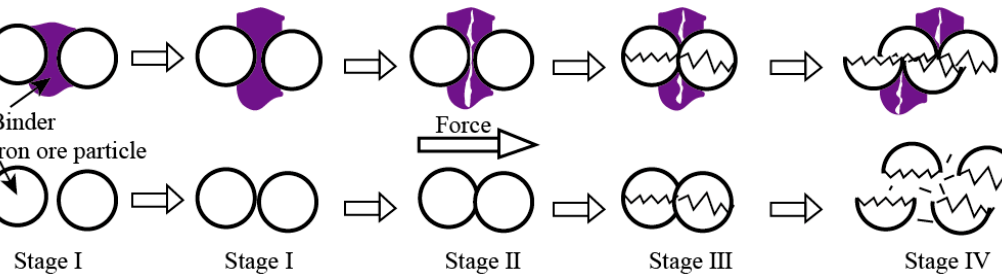
Figure 11. Diagram showing the development of the macroscopic failure process of dry sample ( top five ) and heat ‐ treated sample ( bottom five ).